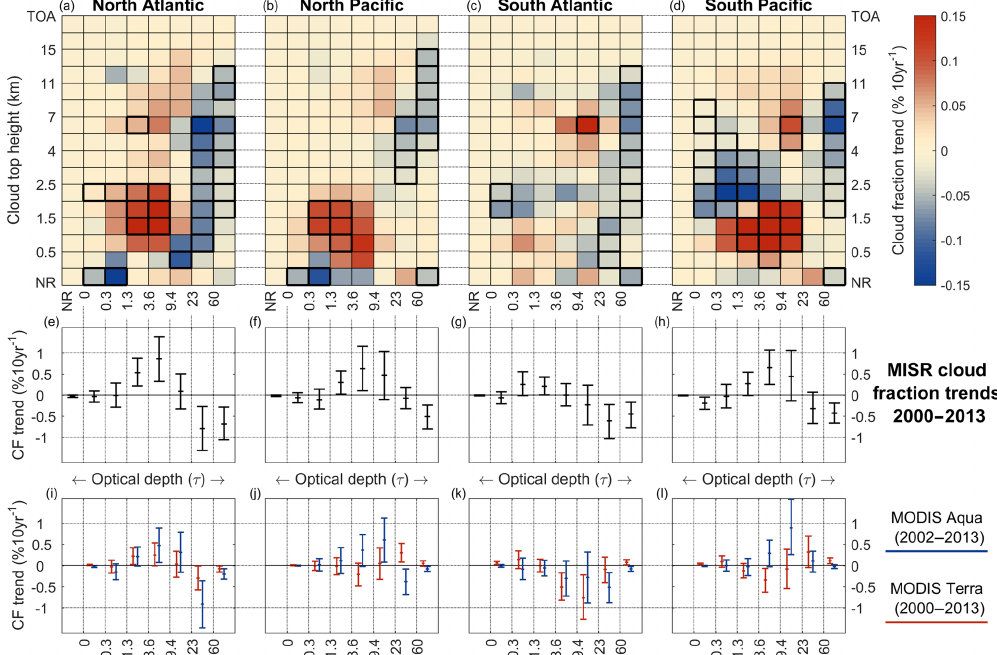
Figure 1. Cloud fraction trends (2000–2013), in percentage per decade, computed for each bin of MISR cloud-top height vs. optical-depth joint histograms (a) – (d) . Trends are spatially averaged over the four extratropical ocean basins listed above each panel (and these regions are depicted in Figs. 2 and 3). Bold bordered bins denote trends that are significant at the 95% level. The middle set of panels (e) – (h) show spatially averaged trends in cloud fraction with respect to the optical-depth bins only (summing over all cloud-top height bins), with whiskers denoting 95% confidence intervals. The bottom panels (i) – (l) show similar cloud optical-depth trends for MODIS Aqua (blue) and Terra (red). The MODIS CTH-OD product uses slightly different optical-depth bins and two of the MODIS high optical-depth bins have been summed over to create one OD > 60 bin for easier comparison with the MISR trends. MISR “no retrieval” bins, denoted “NR,” include cases where either the cloud-top height or optical-depth retrieval failed. MISR observed a significant reduction in cloud fraction in one or both of the τ > 23 bins in each ocean basin, and three (all but the South Atlantic) show a significant increase in low-level cloud of moderate optical thickness. MODIS Aqua is largely consistent with MISR (it shows increases in clouds of moderate optical thickness in the same three basins, and differs mostly in that it shows no statistically significant decrease in clouds with an optical thickness greater than 23 in the South Pacific). MODIS Terra is less consistent with MISR (and MODIS Aqua) and shows smaller decreases or slight increases in clouds with an optical thickness greater than 23, likely due to calibration issues (see Sect. 2 of text for